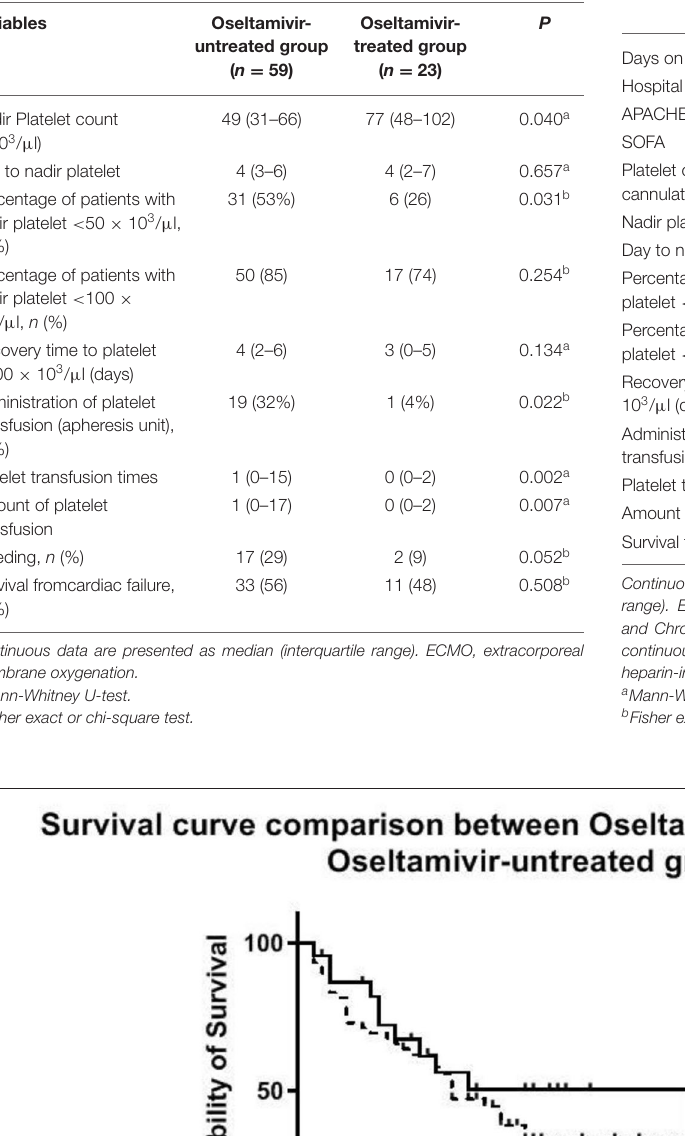
Frontiers in Cardiovascular Medicine |